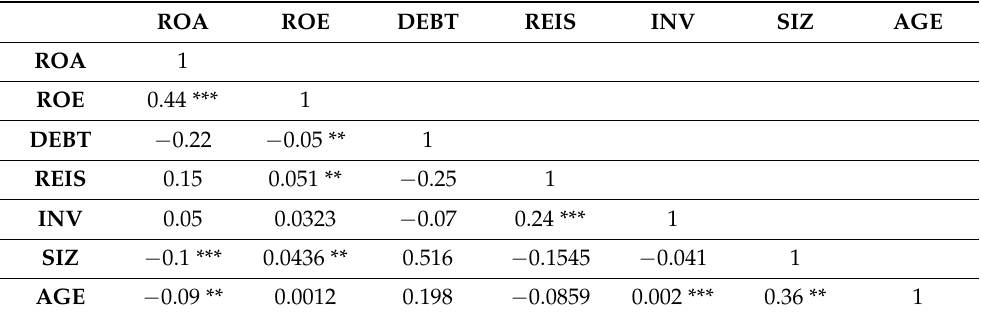
Table 3. Correlation